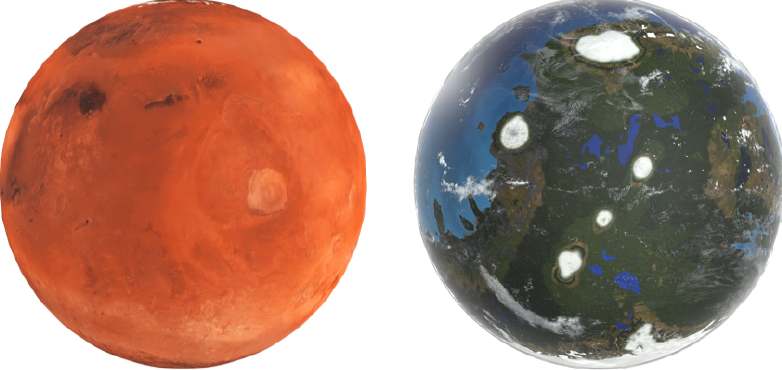
Figure 9. Illustration of Mars before and after